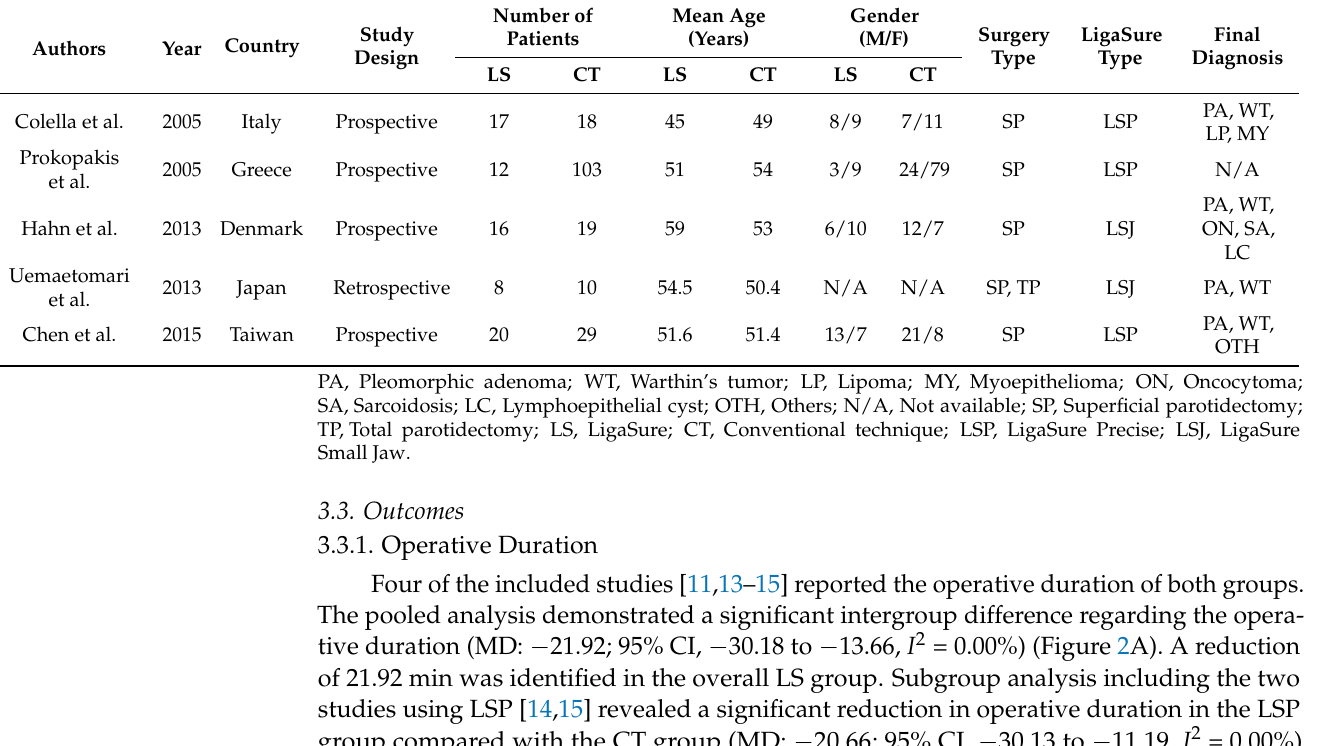
Figure 1. Flow diagram of the literature search. Table 1. Characteristics of the included